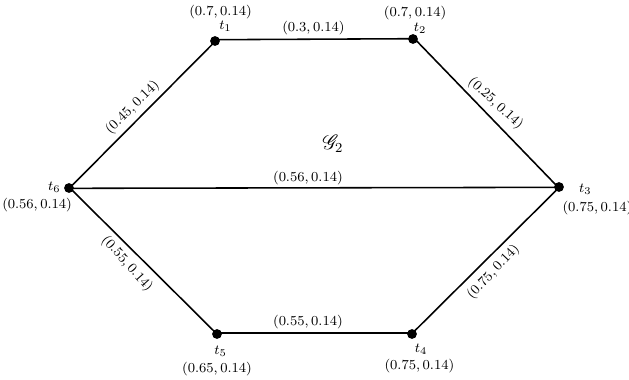
Figure 6.6: Pythagorean fuzzy dual graph Figure 17. Pythagorean fuzzy dual